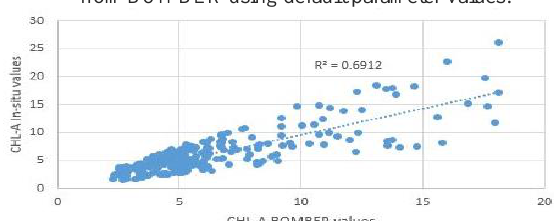
Figure 12. Comparison of in situ chl-a (µg/l) with estimates from BOMBER using inversed parameter